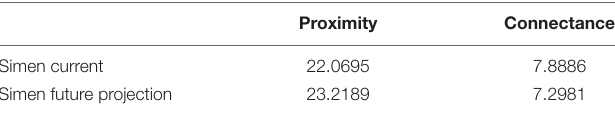
TABLE 2 | Average values for Proximity index and Connectance index for suitable habitat patches in the Simen Mountains, respectively, under current climate and future